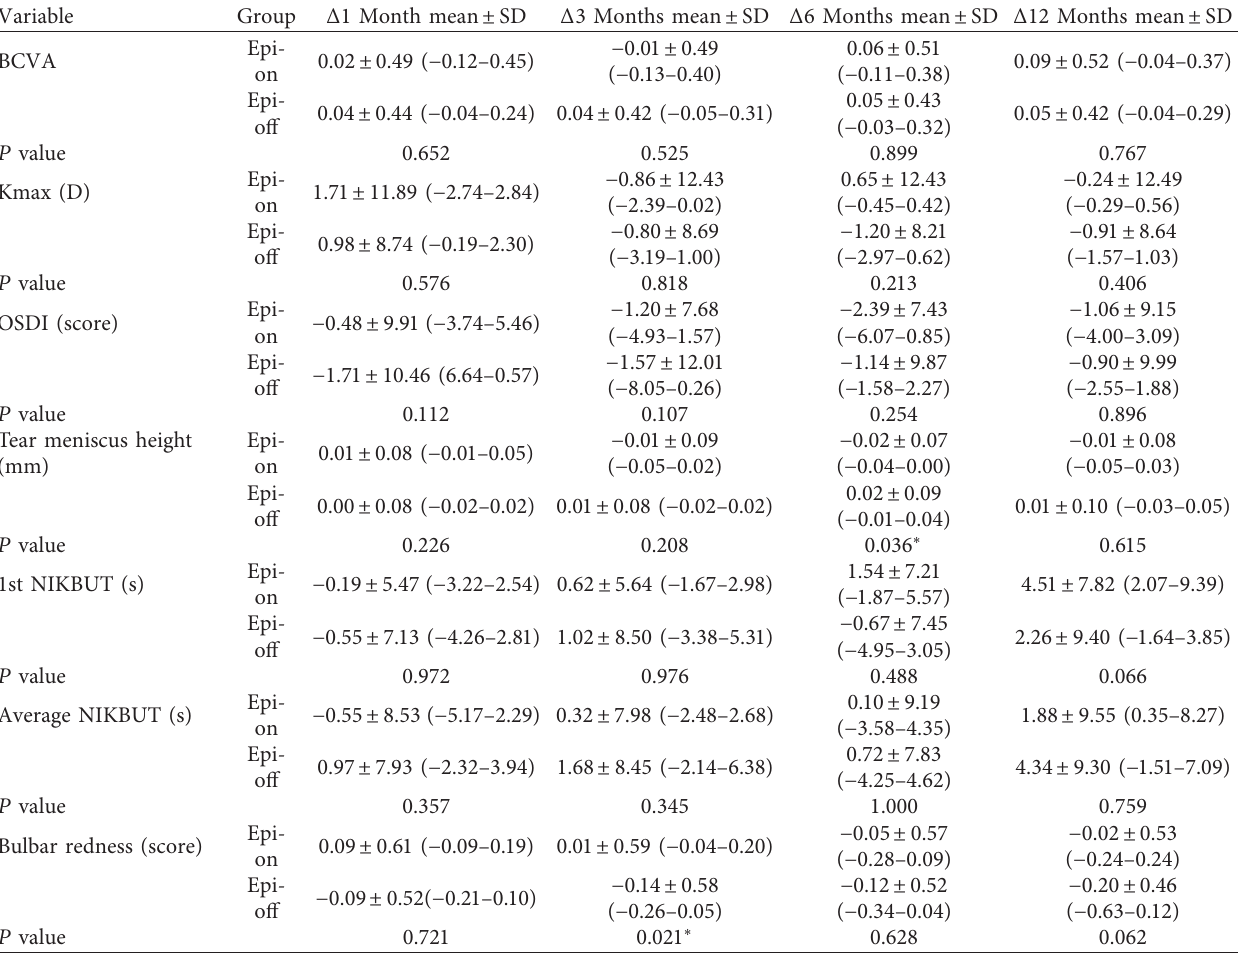
Table 3: Analysis of parameter changes between the two